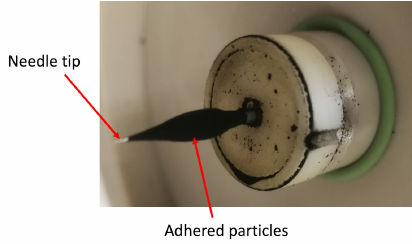
Figure 12. Needle electrode with adhered dust